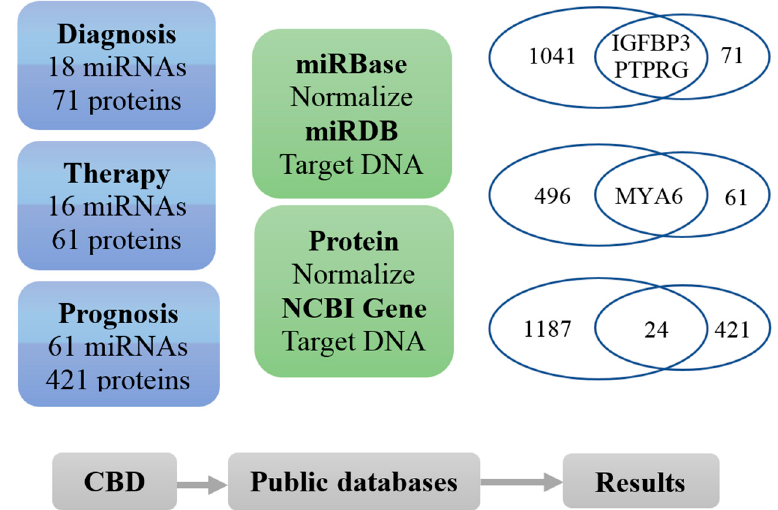
Figure 5. Associations of DNA, RNA and protein biomarkers in diagnosis, therapy and prognosis of CRC. The RNA and protein biomarkers from our CBD were converted to their corresponding genes and the relationships between the overlapping genes were further analysed. There were two genes (IGFBP1 and PTPRG) from both RNA and protein biomarkers which were associated to CRC diagnosis and one gene (MYA6) was related to therapy. However, there were 24 genes which were associated with prognosis.